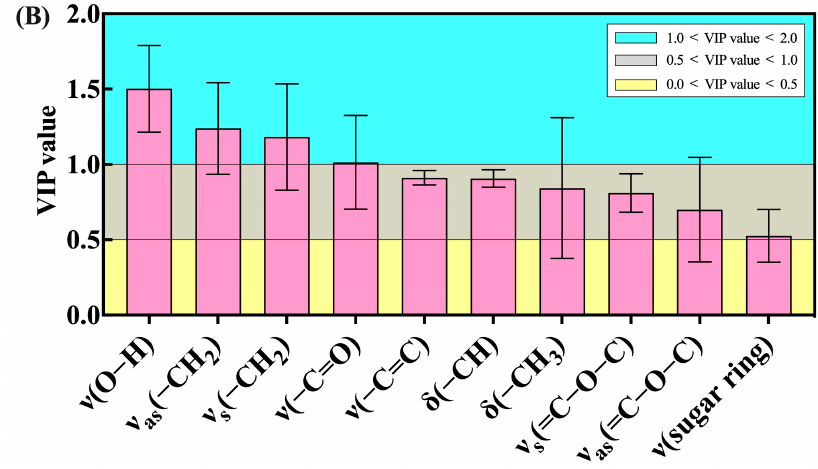
Figure 5. Coefficients plot ( A ) and VIP plot ( B ) of the characteristic absorption peaks in E. sagittatum leaves subjected to FT-IR under the OPLS-DA model.